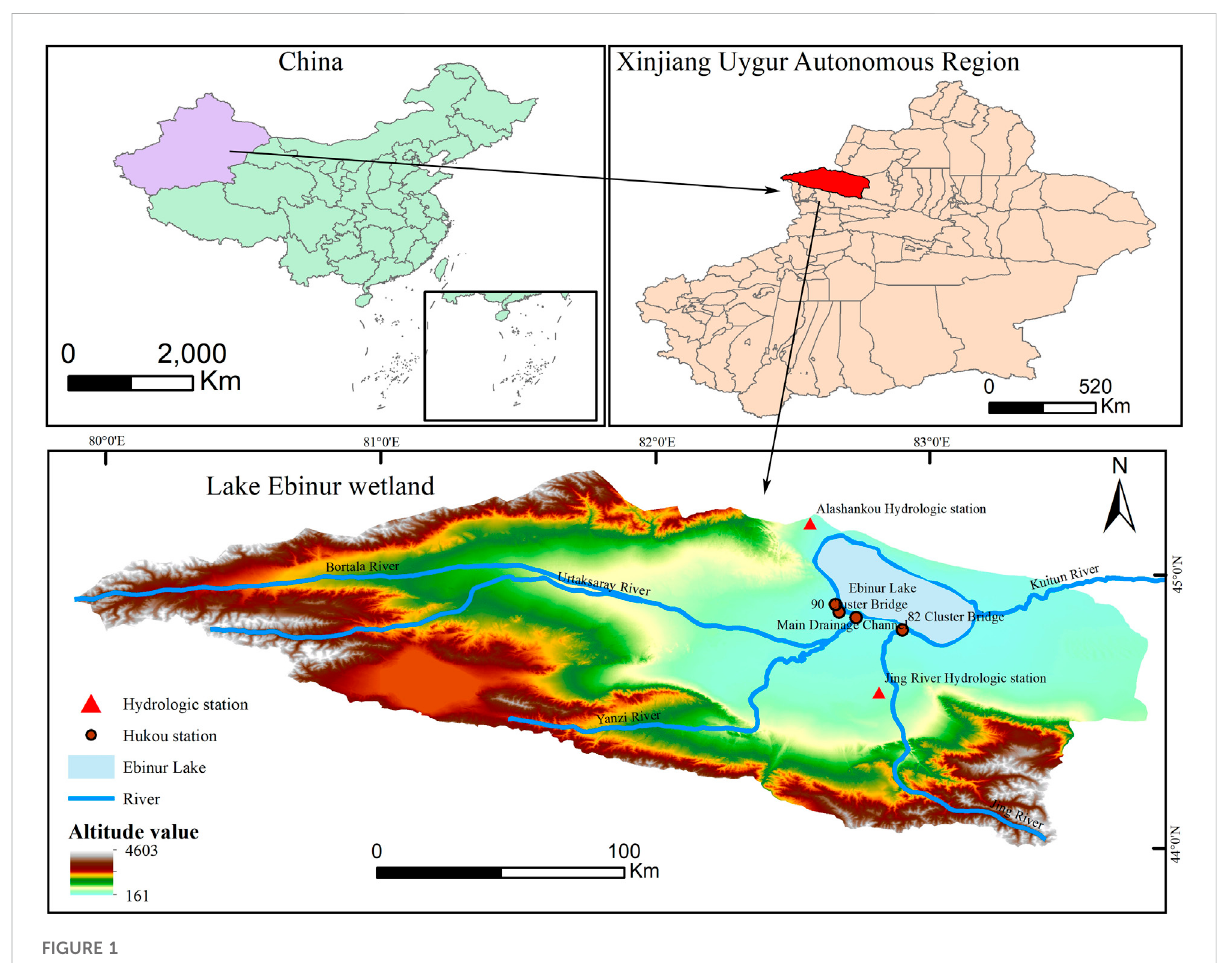
FIGURE 1 Geographical location of the study